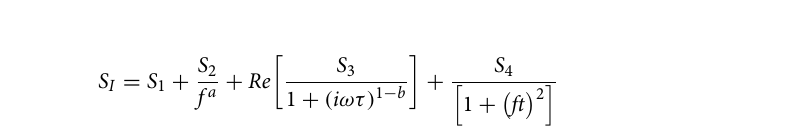
Figure 6. Extracted parameters from current noise spectra taken at T = 100 K and shown in Fig. 5. ( A ) The magnitude of the frequency-independent term extracted from the fits to Eq. (4) in Fig. 5C as a function of photocurrent. The minimal reduction of the Fano factor as compared to the room-temperature data presented in Fig. 2 illustrates that this term is true shot noise. ( B ) The magnitude of the low-frequency Lorentzian term in Eq. (4) seen to emerge below 150 K as a function of photocurrent. The black line indicates a fit to an J 2 sc